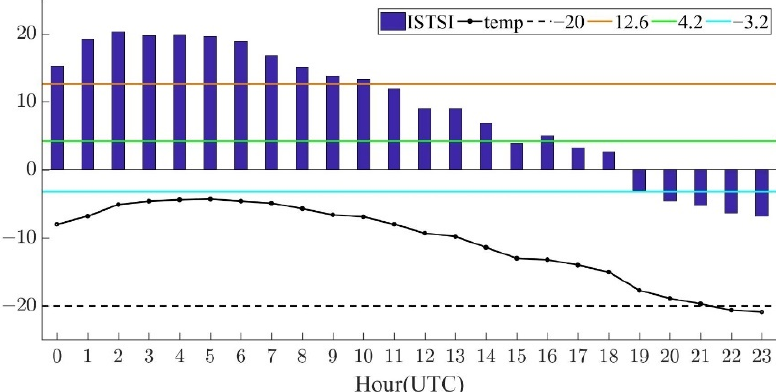
Figure 7. The 24 h change in temperature and ice–snow tourism suitability index ( ISTSI ) at Donggang station on 8 January 2022 (the unit of temperature is °C).